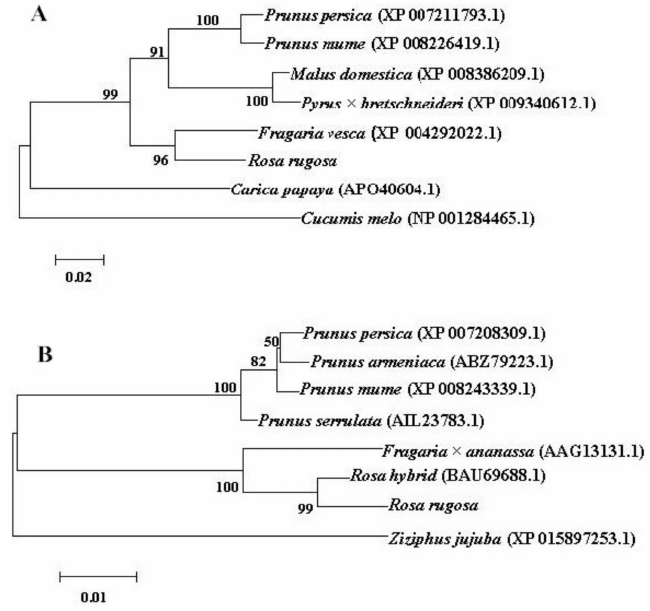
Figure 3. Homology analysis of RrAAAT ( A ) and RrPPDC1 ( B ) gene sequences with NCBI BLAST. The numbers in the cladogram show homology percentage; accession numbers are